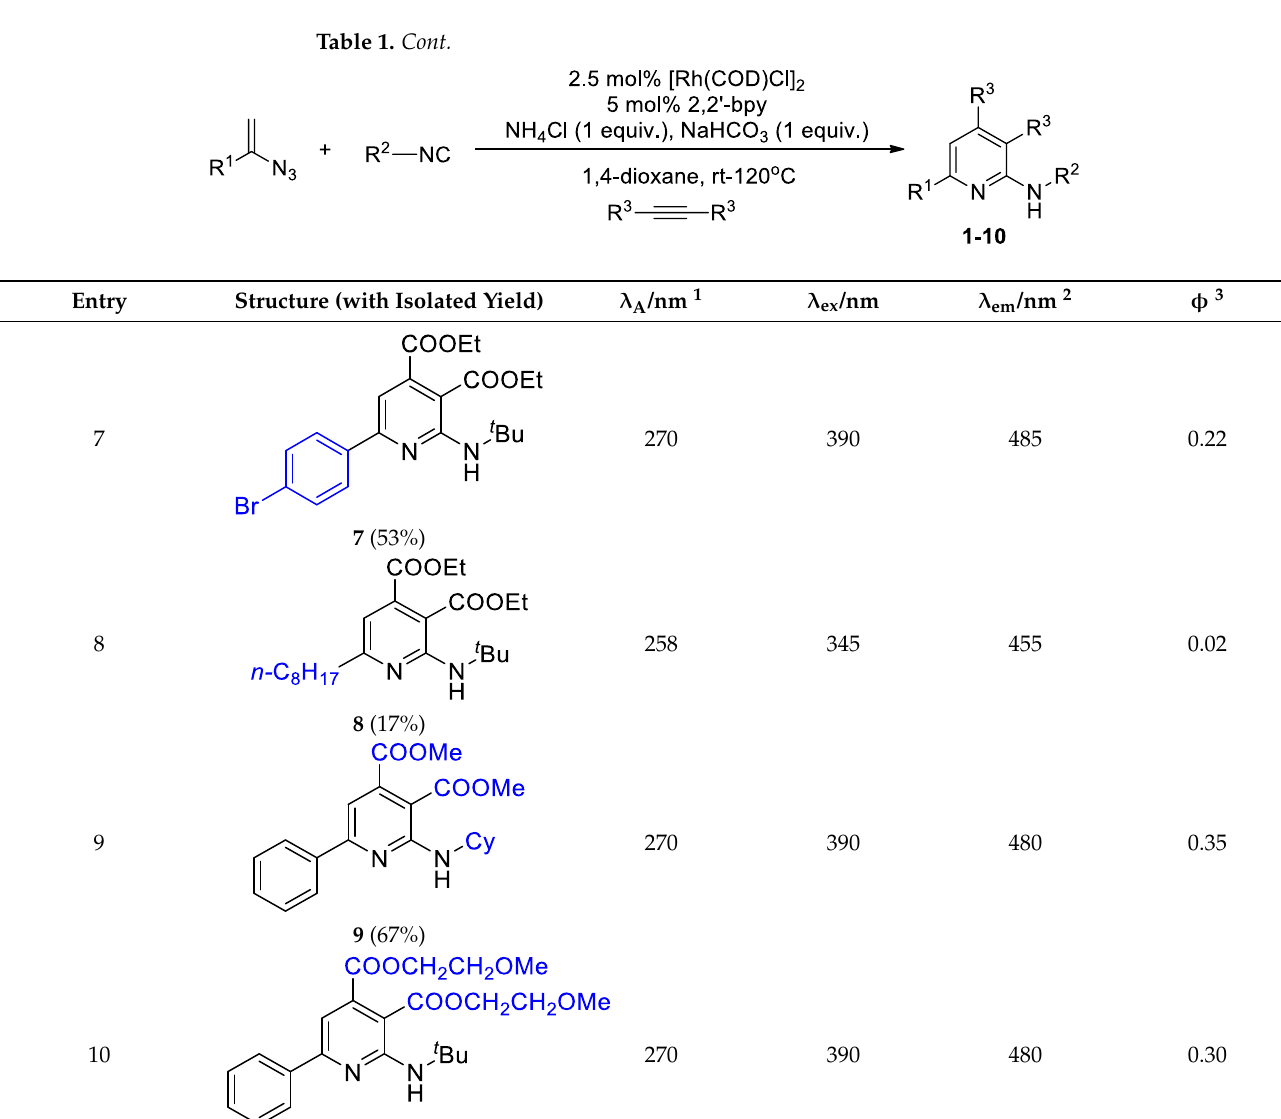
Table 1. Fluorescent Properties of Table 1. Cont.